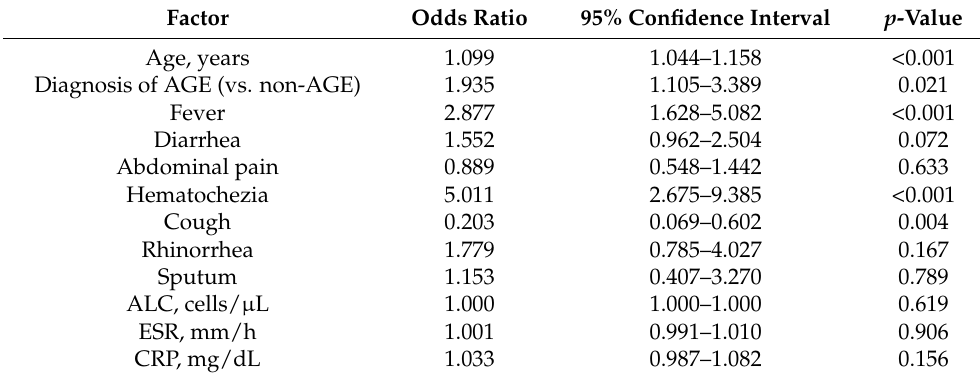
Table 3. Multivariate analysis for significant factors associated with positive mPCR test results.